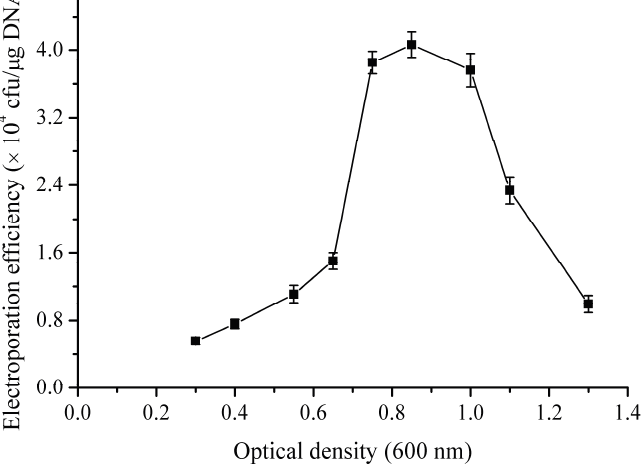
Figure 1. Effects of growth phase of B. subtilis ZK on the electroporation